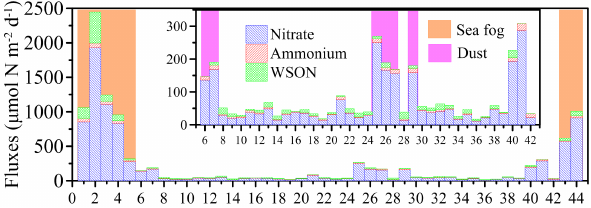
Figure 10. Dry deposition of aerosol nitrogen against sample iden- tification. Nitrate is in blue, ammonium in red and WSON in green. Sample identifications, which match with Table S1, are shown on the x